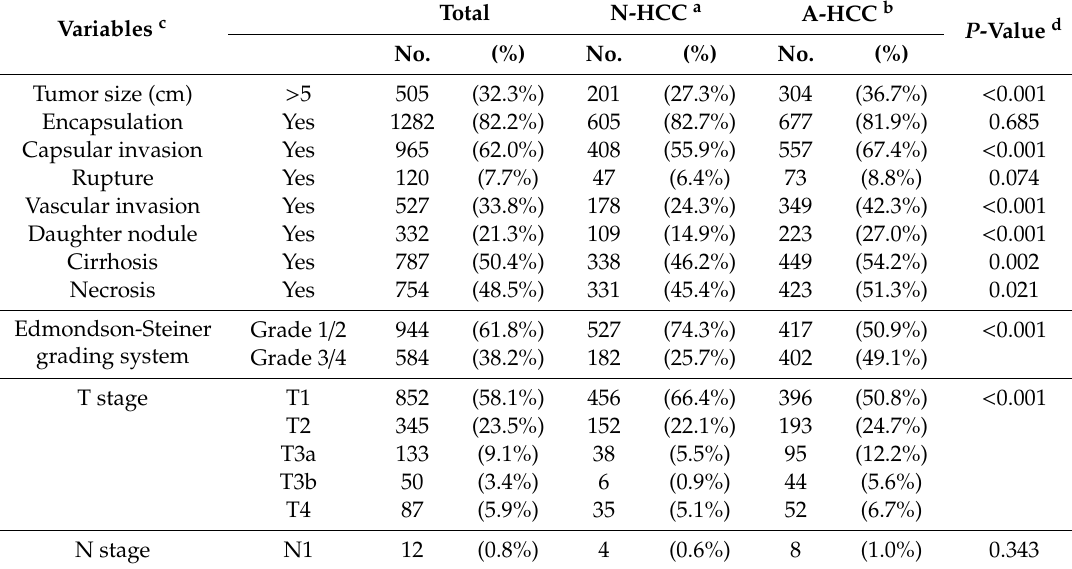
Table 2. Pathologic characteristics of N-HCC a vs. A-HCC b ( n =